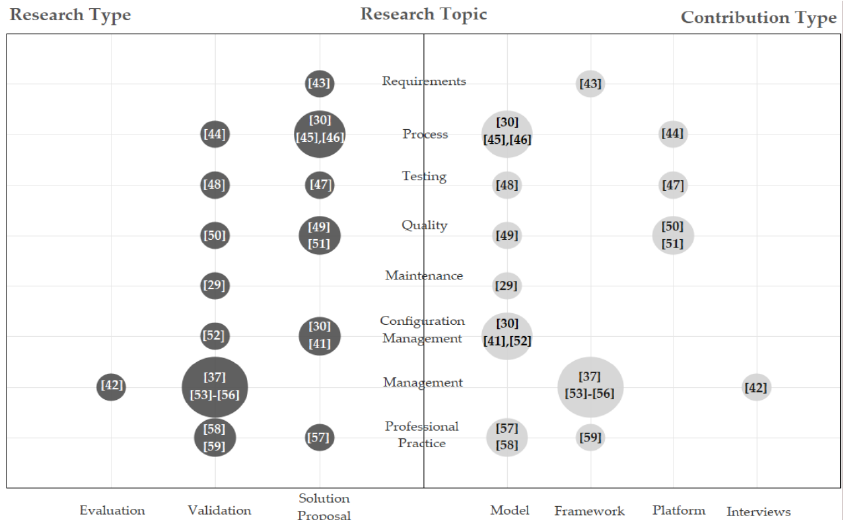
Figure 4. Visualization of our systematic map in the form of a bubble